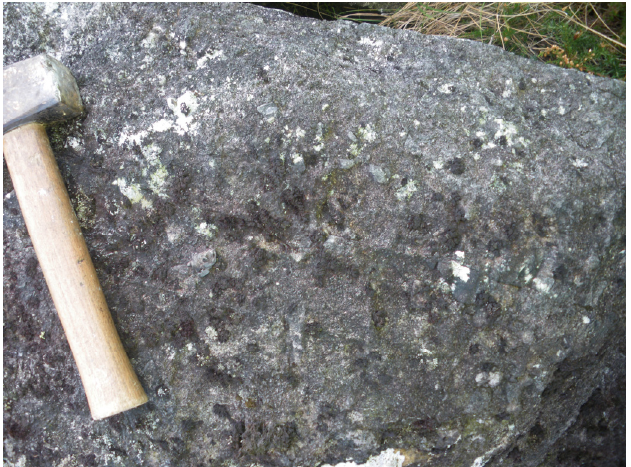
Figure 13. Slievenaglogh, County Louth: vent agglomerate with irregular, unsorted clasts in fine matrix.